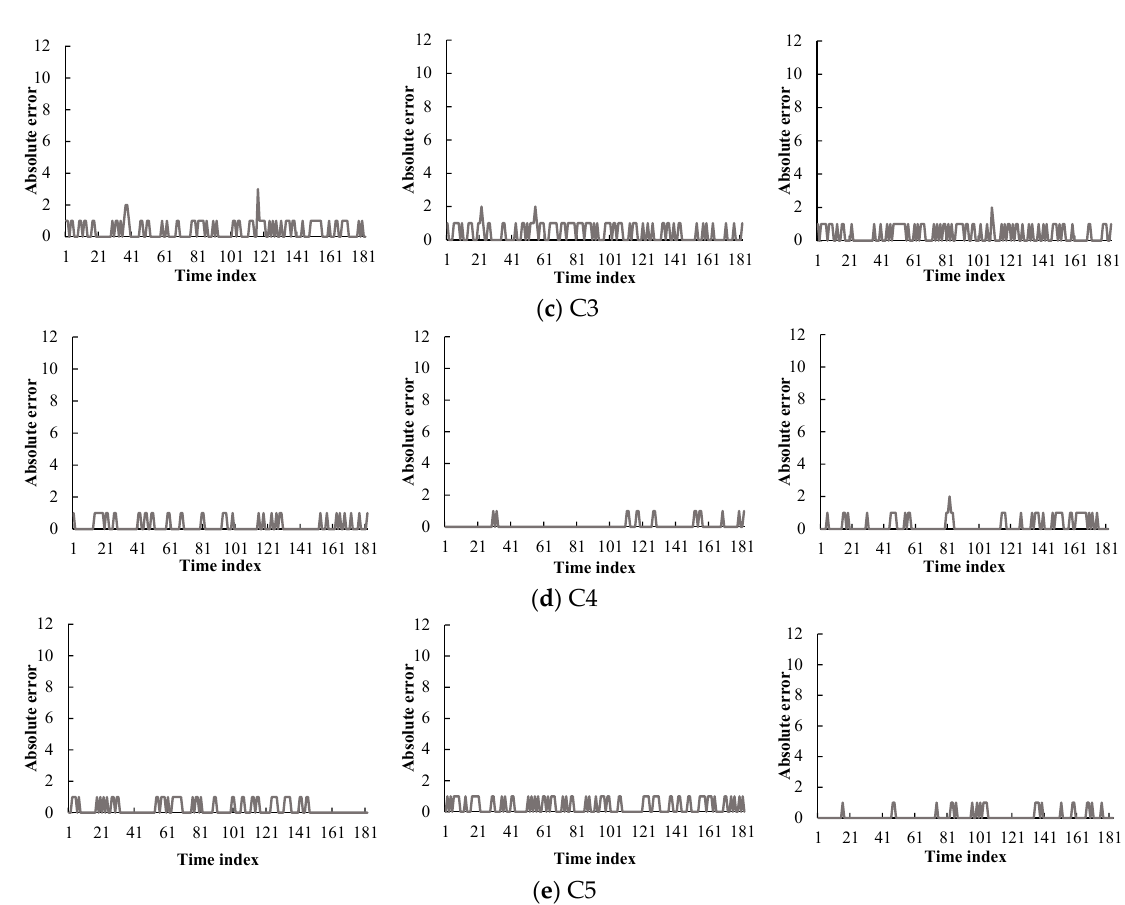
Figure 12. Traffic flow prediction errors at five cone-zones during February ( left ), March ( middle ), and April ( right ), respectively.